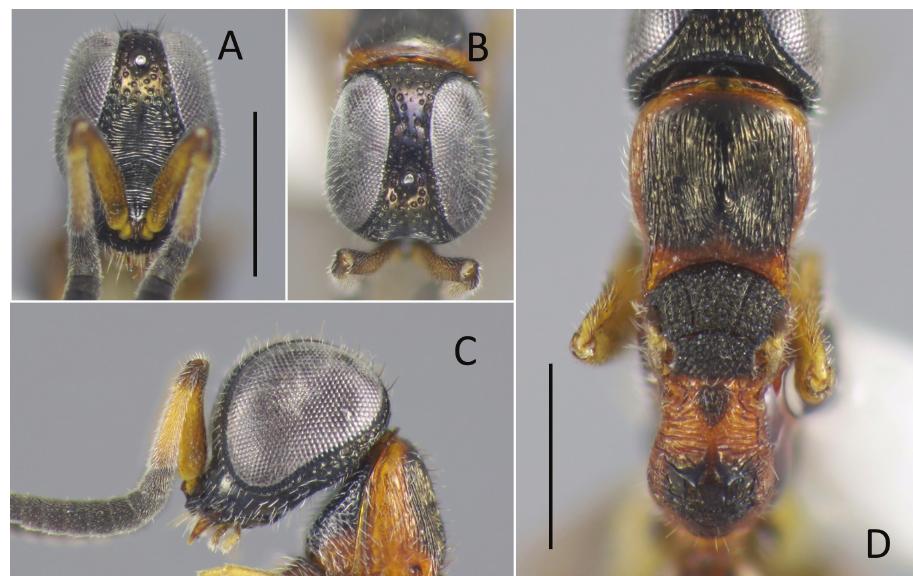
Figure 7. Nipponosega lineata sp. nov., holotype ♀ A head in frontal view B ditto, dorsal view C ditto, lateral view D vertex and mesosoma. Scale bars: 0.5